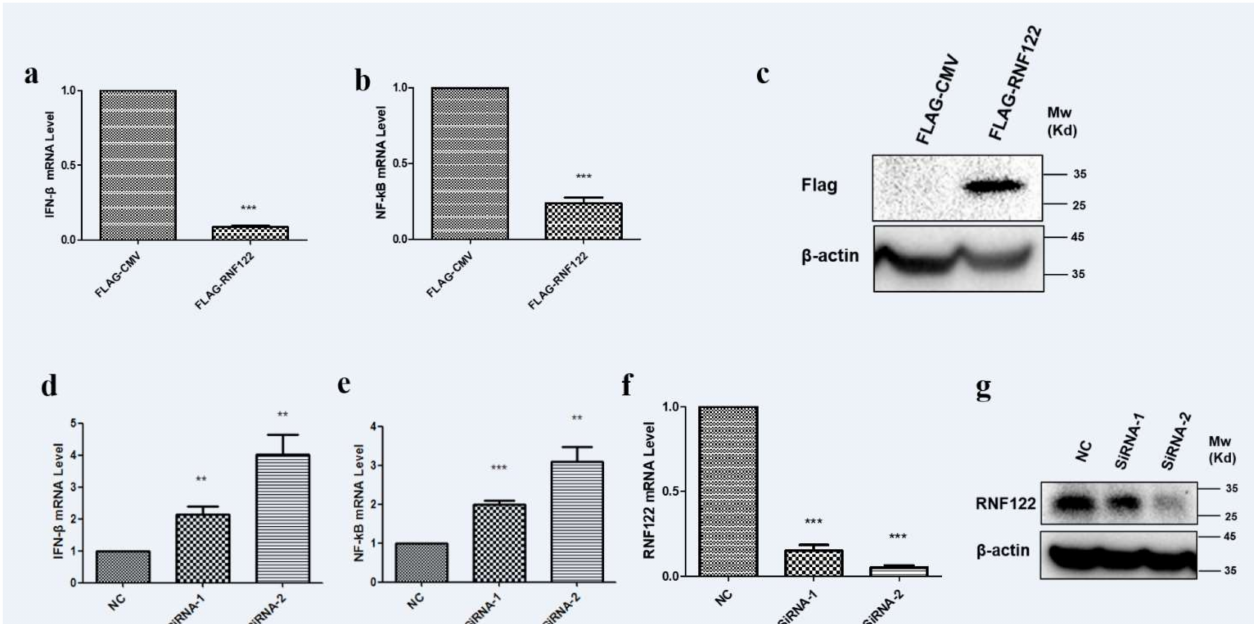
Figure 8. Porcine RNF122 negatively regulated type I interferon signaling pathway. ( a , b ) 3D4/21 cells were transfected with Flag-CMV or Flag-RNF122, 24 h later, mRNA loads of IFN β and NF- κ B were tested by qRT-PCR. ( c ) 3D4/21 cells were transfected with Flag-CMV or Flag-RNF122, 24 h later, RNF122 was tested by WB. ( d – f ) 3D4/21 cells were transfected with SiRNA or not, 24 h later, mRNA loads of IFN- β , NF- κ B and RNF122 were tested by qRT-PCR. ( g ) 3D4/21 cells were transfected with SiRNA or not, 24 h later, RNF122 was tested by WB. ** p < 0.01; *** p < 0.001 (analysis of two-way ANOVA attended by Bonferroni post-test). Data are representative of three independent